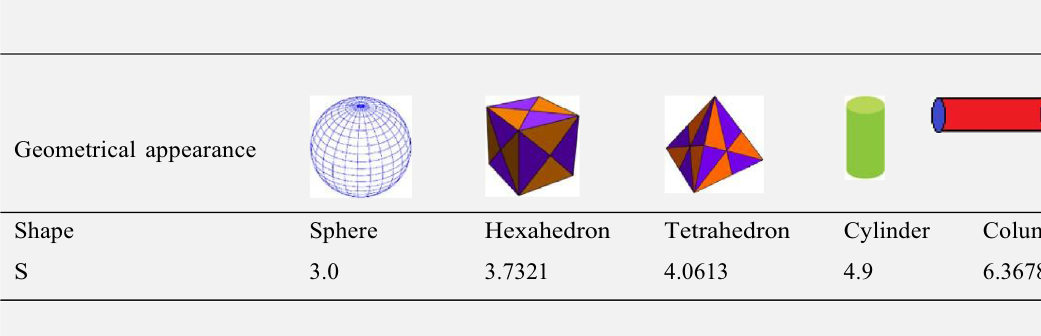
Table 6. Shape factors of nanoparticles.